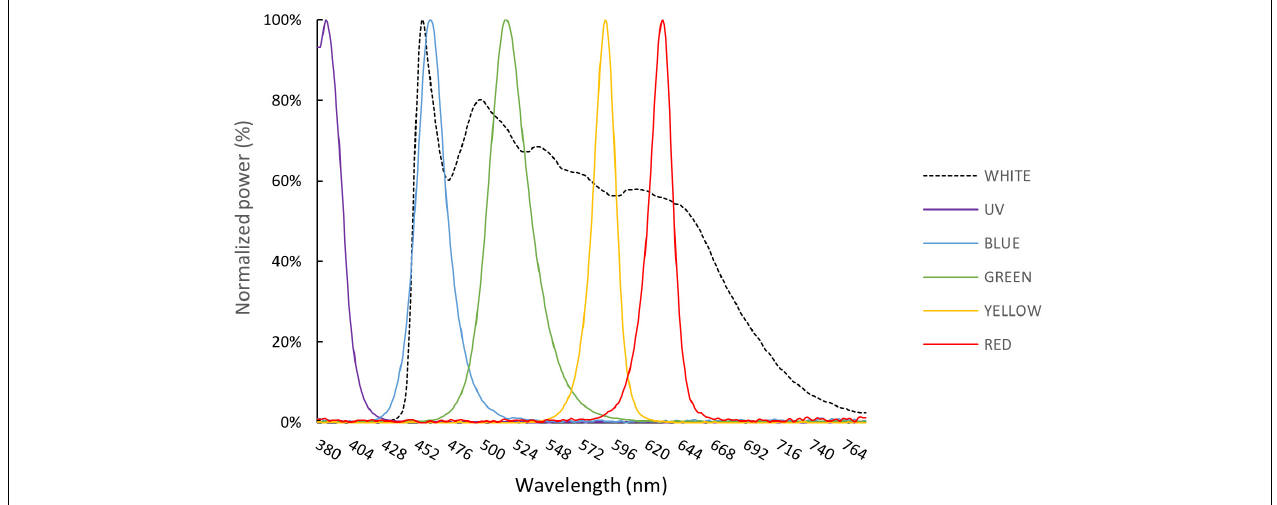
FIGURE 2 | Spectral emissions for each color of LED utilized in this study, measured at a distance of 15 cm and standardized to the peak emission.